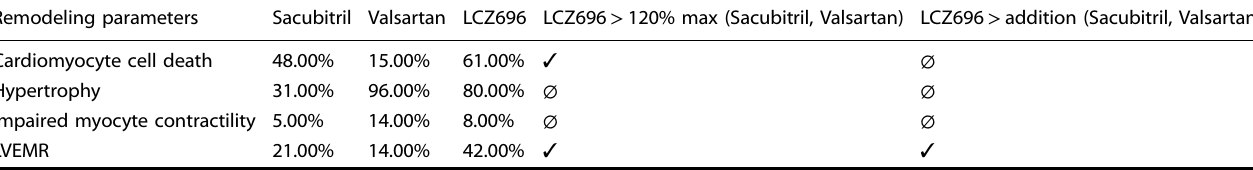
Table 1. Relationships between the drugs and pathologies under study Remodeling